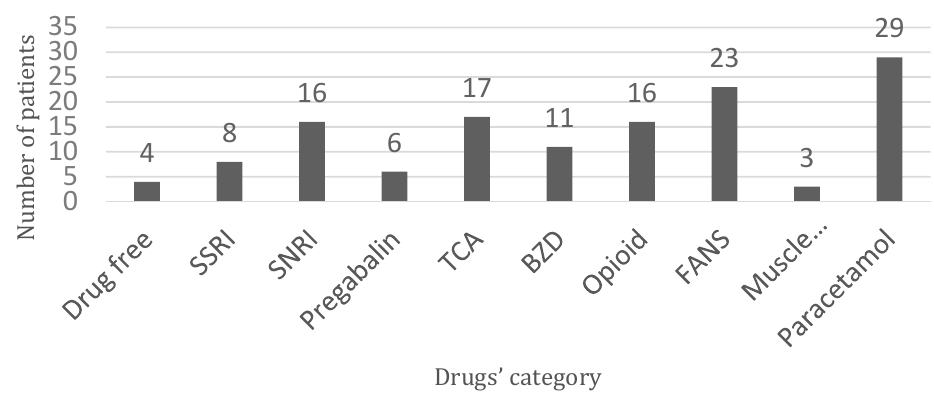
Figure 1. Concomitant pharmacological fibromyalgia syndrome (FMS) treatments in 60 eligible patients. SSRI = serotonin selective reuptake inhibitors; SNRI = serotonin noradrenaline selective inhibitors; GBPs = gabapentinoids; TCA = tricyclic antidepressants; BZD = benzodiazepines; OPI = opiates; NSAIDs = non-steroidal anti-inflammatory drugs; MR = muscle relaxants; ACT = acetaminophen.